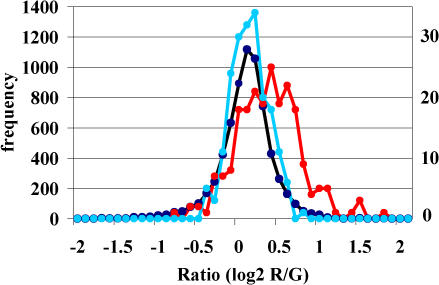
Gene Expression Profiling of puf3 MutantsDistribution of average Cy5/Cy3 fluorescence ratios from three independent microarray hybridizations comparing mRNA levels of puf3Δ with wild-type cells grown in minimal media with glycerol. The left frequency axis refers to all genes (black line); the axis to the right refers to Puf3p and Puf4p (control) targets, shown as red and blue lines, respectively. Relative expression levels of the 220 Puf3p mRNA targets in puf3Δ cells were selectively increased compared to all other mRNAs analyzed (p < 10−34), whereas Puf4p targets were not (p > 0.05). Thirty-nine genes involved in aerobic respiration (according to GO annotation and SGD), but not bound by Puf3p, were similarly enriched (p < 5 × 10−5) in the puf3 mutant as random sets of 39 Puf3p targets (p < 10−6). Likewise, 220 randomly selected mRNAs coding for mitochondrial proteins that were not associated with Puf3p in the experiments herein were weakly enriched in the mutant (p < 10−8).